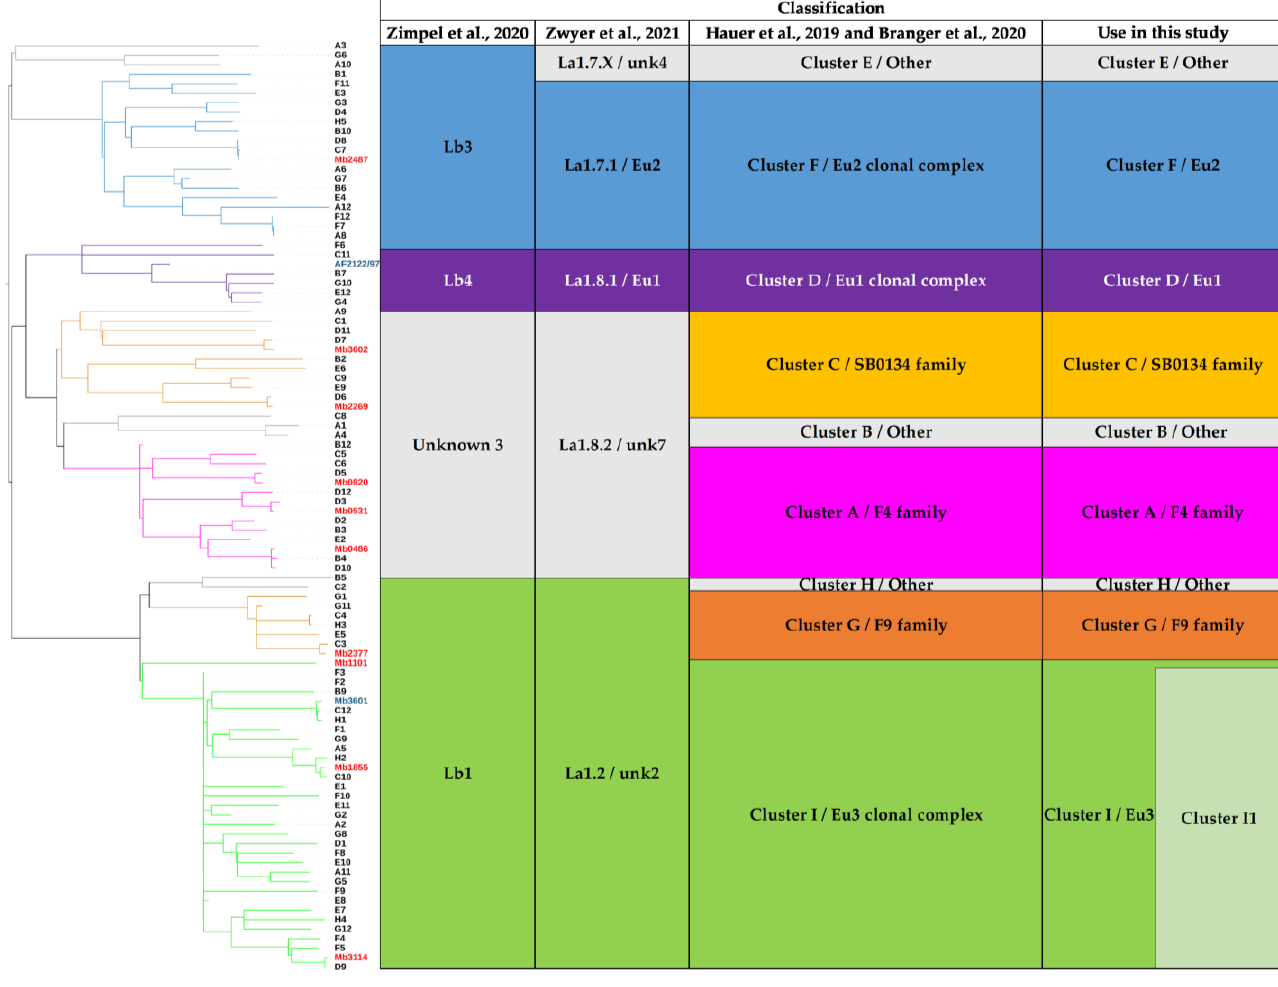
Figure 6. Phylogenetic tree of 98 M. bovis genomes. The two previous reference genomes (Mb3601 and AF2122/97) are marked in blue. The 10 new complete genomes are indicated in red. The phylogenetic tree is based on 7023 whole genome SNPs. The strains are grouped according to the previous classification Hauer et al. 2019, Zwyer et al. 2021 and Guimares et al. 2020 [7,11,16]. The colors of the M. bovis groups are in accordance with the previously described clusters and lineages Hauer et